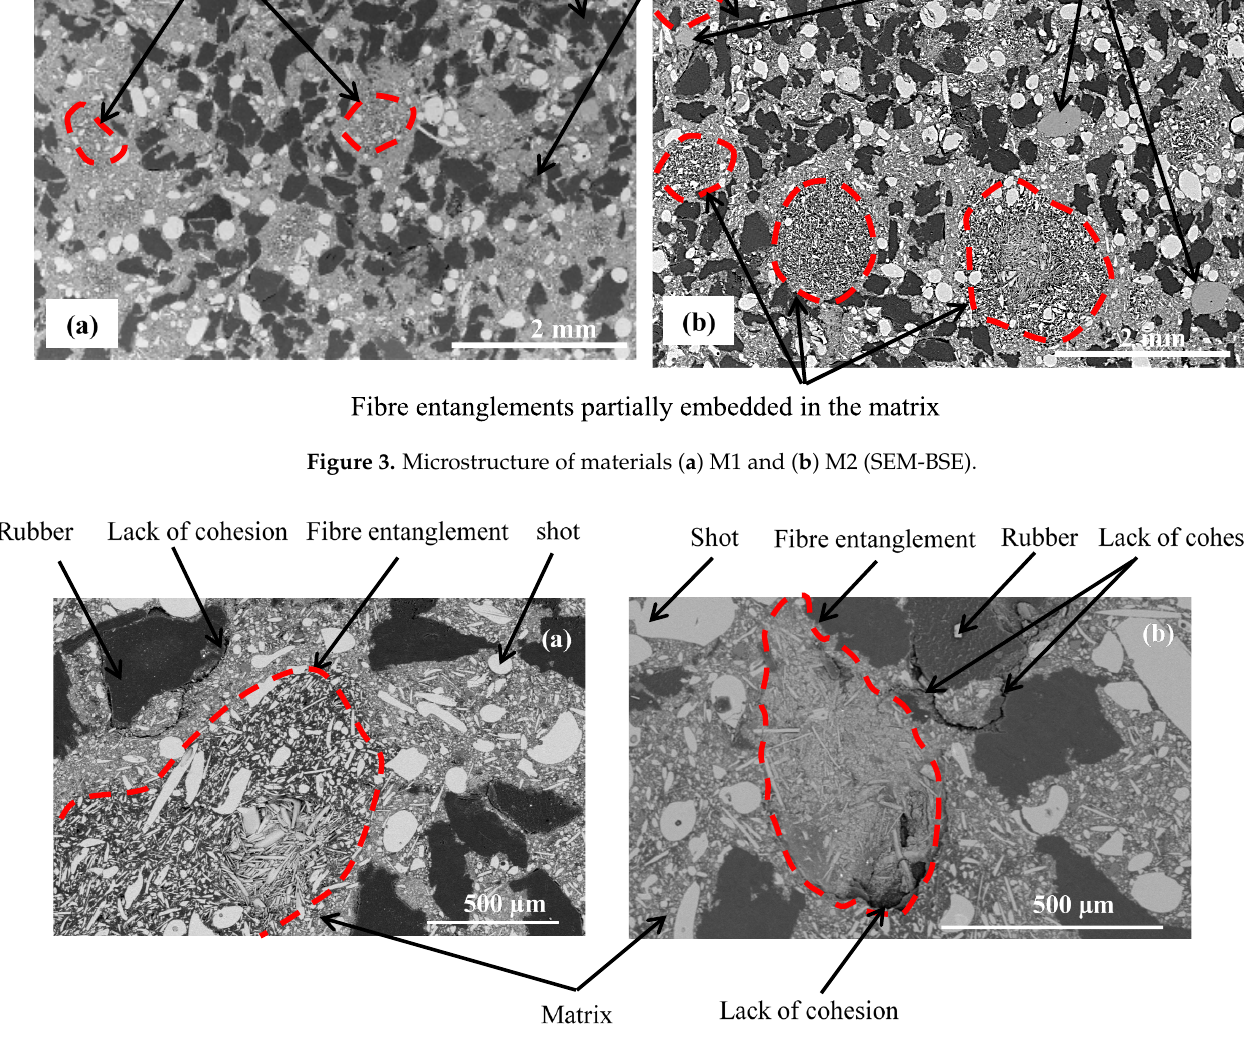
erations correspond to matrix particles, which indicates that they were not well dispersed